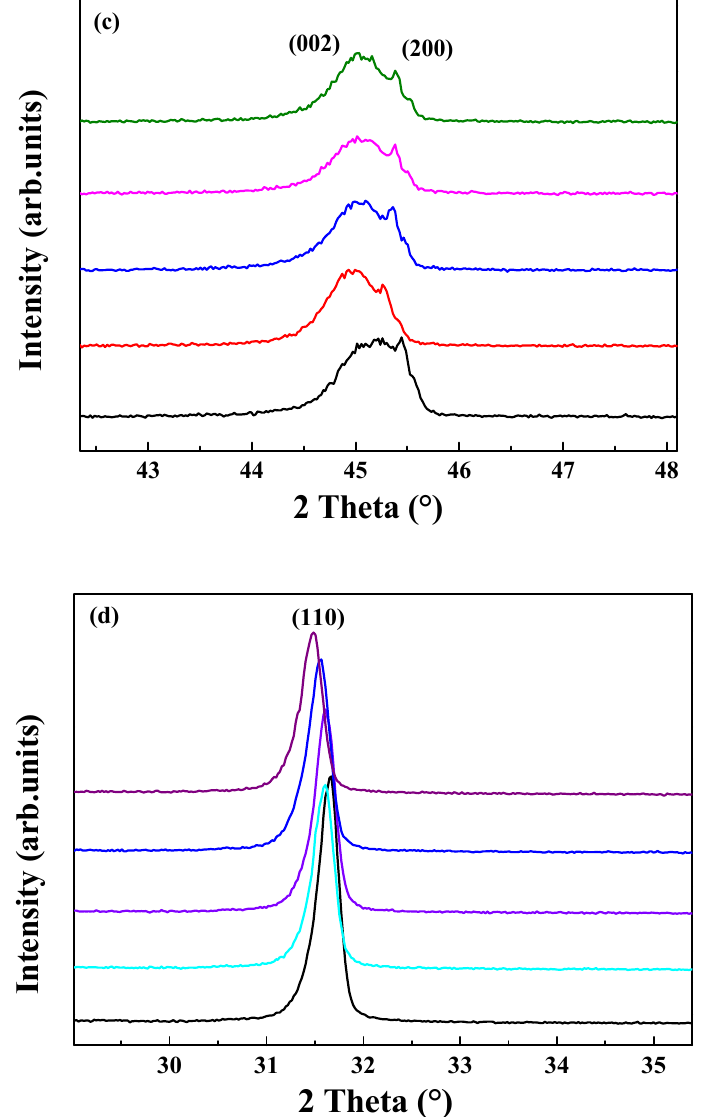
Figure 3. ( a ) X-ray diffraction patterns of the Ce 0.04 Y y doped BCZT ceramics. ( b ) X-ray diffraction patterns of the Ce x Y 0.02 doped BCZT ceramics and ( c ) X-ray diffraction patterns of the Ce 0.04 Y y doped BCZT ceramics enlarge patterns near 40–50°. ( d ) X-ray diffraction patterns of the Ce x Y 0.02 doped BCZT ceramics enlarge patterns near 30–35°.